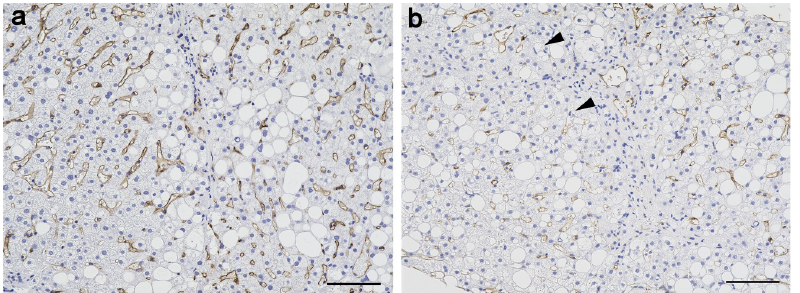
Fig 1. Fc γ RIIb expression and localization in liver tissues of patients. Representative light microscopic images of patients who were diagnosed as NASH (a: NAS, 2; b: NAS, 8). Fc γ RIIb signals detected with DAB (brown) are distributed in LSECs. In b, arrowheads indicate LSECs that do not detect Fc γ RIIb signals. Nuclei were counterstained with hematoxylin (blue). Scale bars represent 100 μ m.